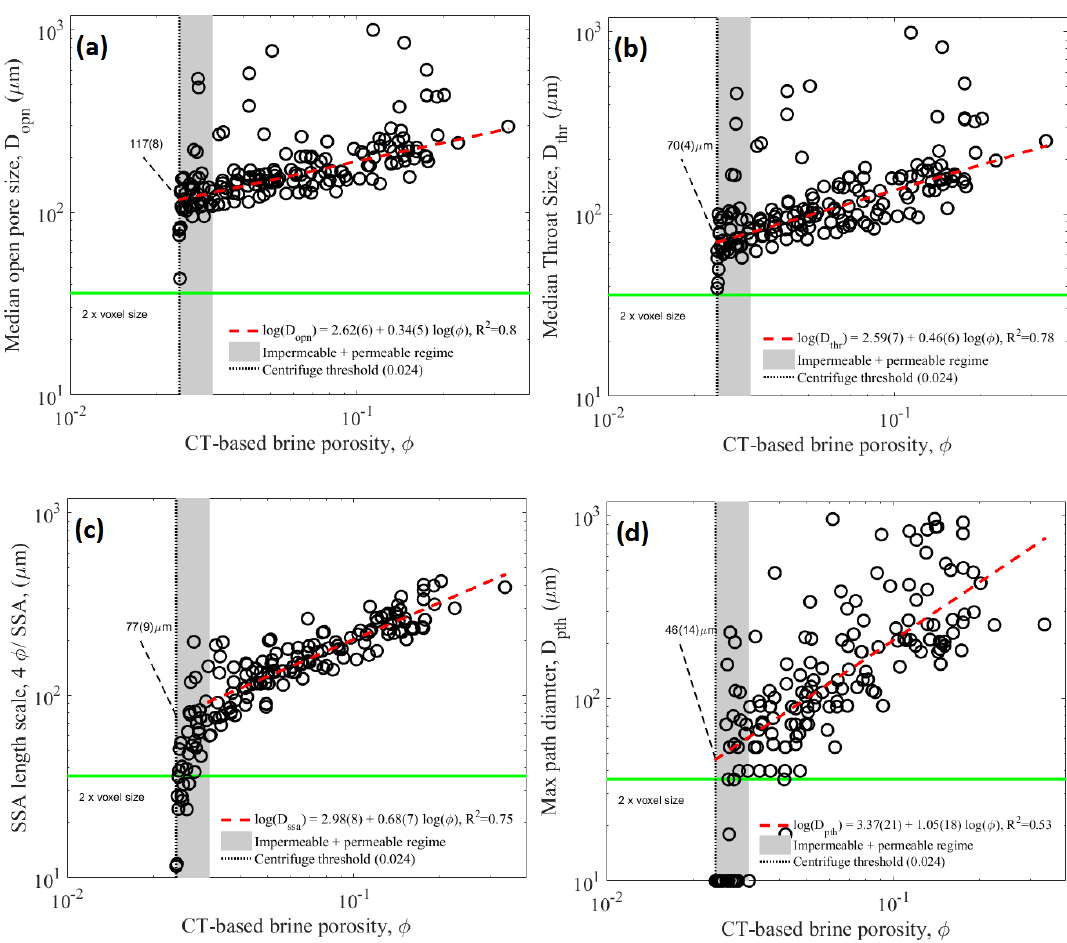
Figure 11. Characteristic pore scales and their dependence on brine porosity. (a) Median open-pore size D opn ; (b) median throat size D thr ; (c) pore scale based on specific surface area D ssa ; (d) maximum path diameter D pth . For all length scales a power law D ∼ φ d has been determined by double-logarithmic least-squares fit, shown as a dashed red line. The fit is given in the legend, with numbers in brackets giving the uncertainties in the last decimal. For D ssa the fit is only based on data with φ > 0 . 031, outside the regime where impermeable samples are found. The critical pore scales are obtained where the dashed red lines cut the percolation threshold φ c = 0 . 024. The Nyquist criterion (2 × voxel size) is shown as a horizontal green